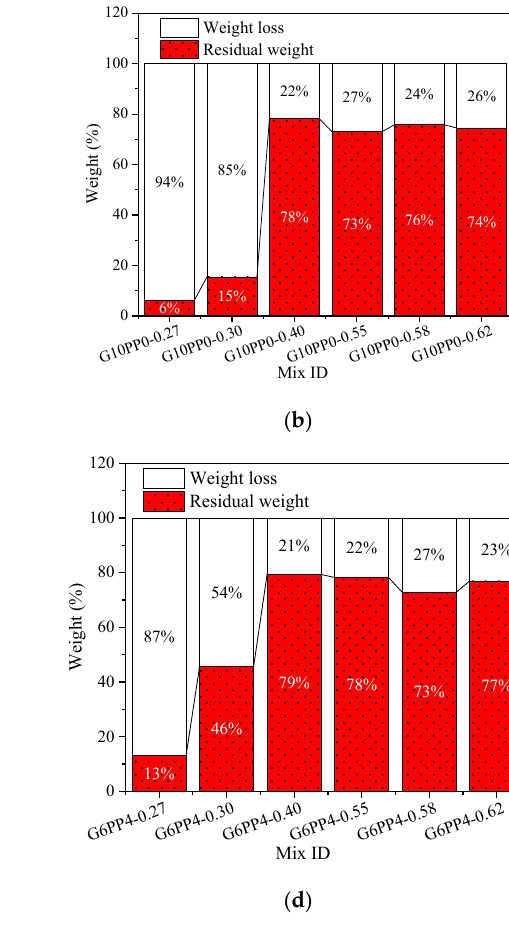
Figure 4. The weight loss and residual weight of mortar samples after wear abrasion test: ( a ) Wear abrasion test result of group 1; ( b ) Wear abrasion test result of group 2; ( c ) Wear abrasion test result of group 3; ( d ) Wear abrasion test result of group 4.